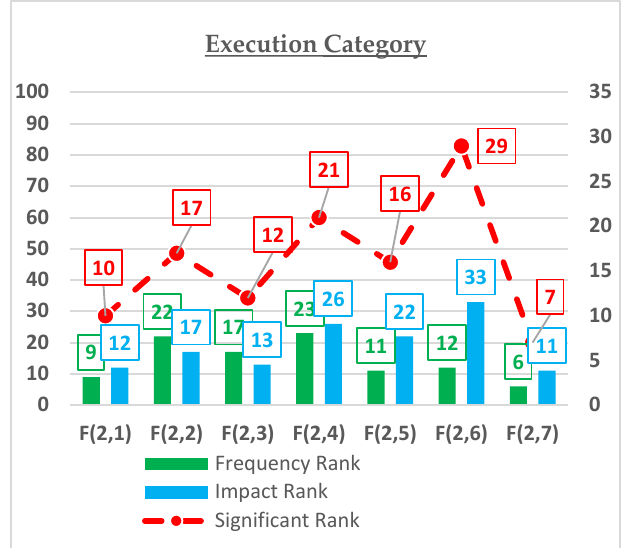
Figure 8. Significant risks in the execution category.